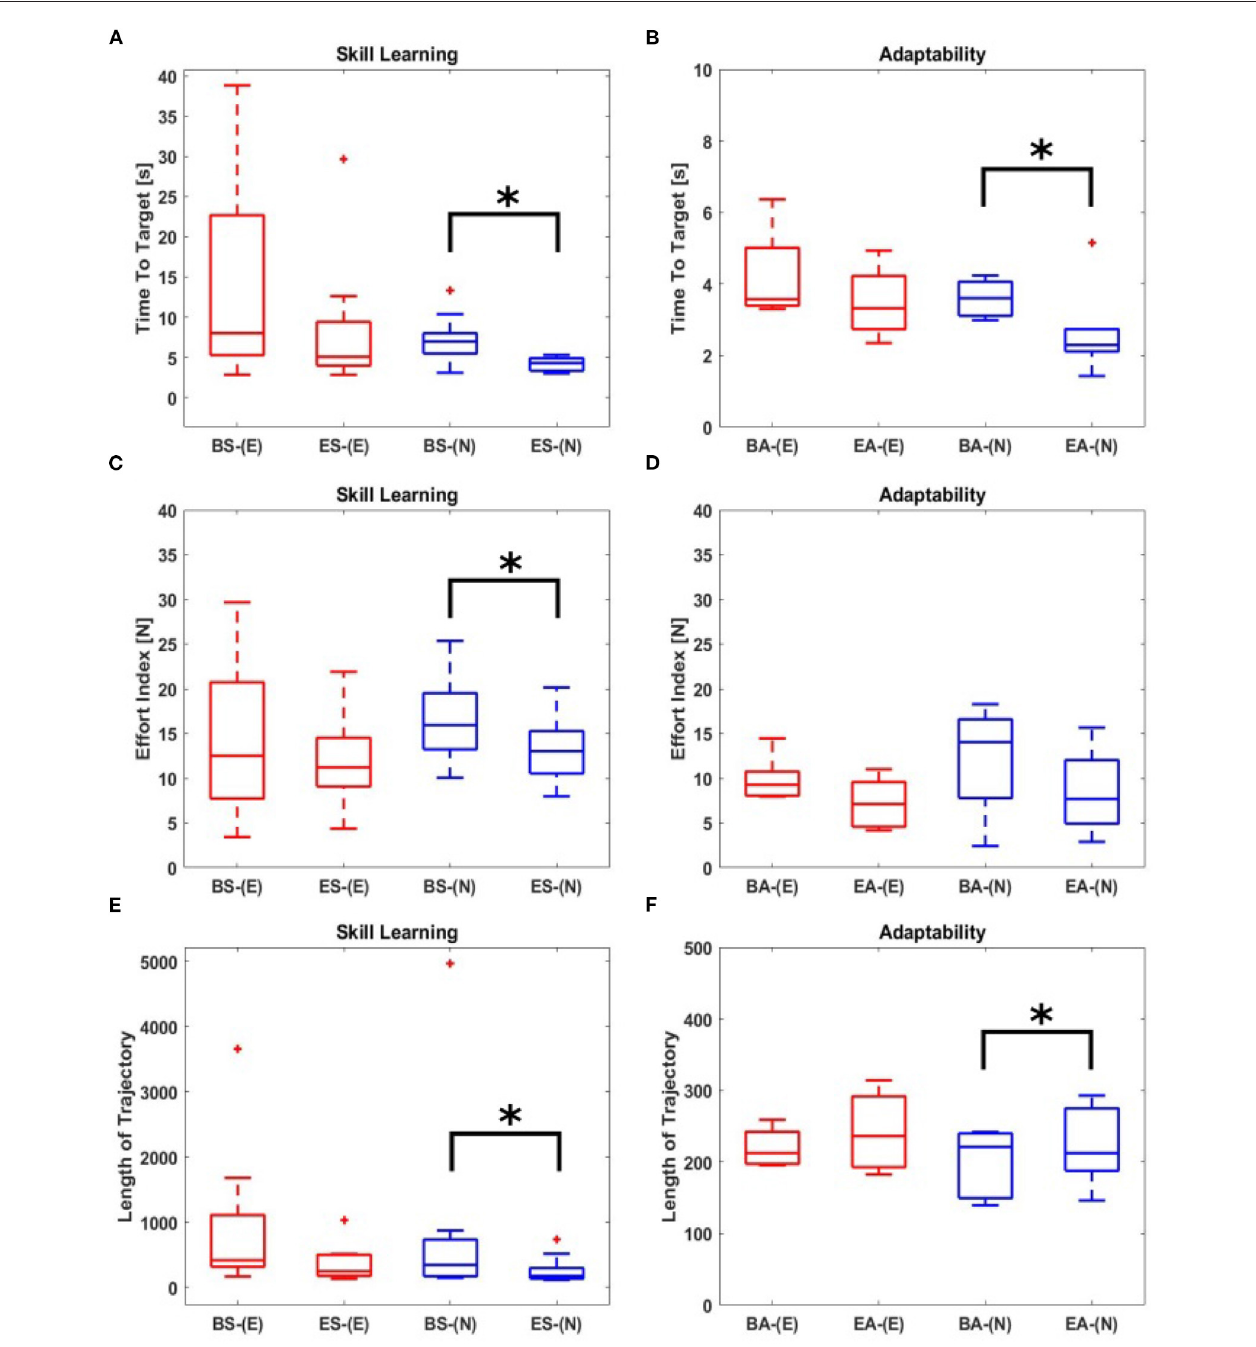
FIGURE 3 | Summary of performance measures: experimental groups: N-N or N-E . Red box plots indicate the participant was paired with the expert. Blue box plots indicate the participant was paired with another novice. Asterisks denote significant differences ( p < 0.05). “skill learning”; time points: the last TS of B-S [BS-(N) for N-N group and BS-(E) for N-E group] and the first TS of E-S (ES-(N) for N-N group) and ES-(E) for N-E group]; (A) “time to target” - N-N: p = 0.0020; N-E: p = 0.0781. (C) “effort index” - N-N: p = 0.0210; N-E: p = 0.6406. (E) “length of trajectory” - N-N: p = 0.0371; N-E: p = 0.0625. “adaptability”; time points: the last TS of B-A [BA-(N) for N-N group and BA-(E) for N-E group] and the first TS of E-A [EA-(N) for N-N group and EA-(E) for N-E group]; (B) “time to target” - N-N: p = 0.0332; N-E: p = 0.5576. (D) “Effort index” - N-N: p = 0.1943; N-E: p = 0.3279. (F) “Length of trajectory” - N-N: p = 0.0320; N-E: p = 0.1329.